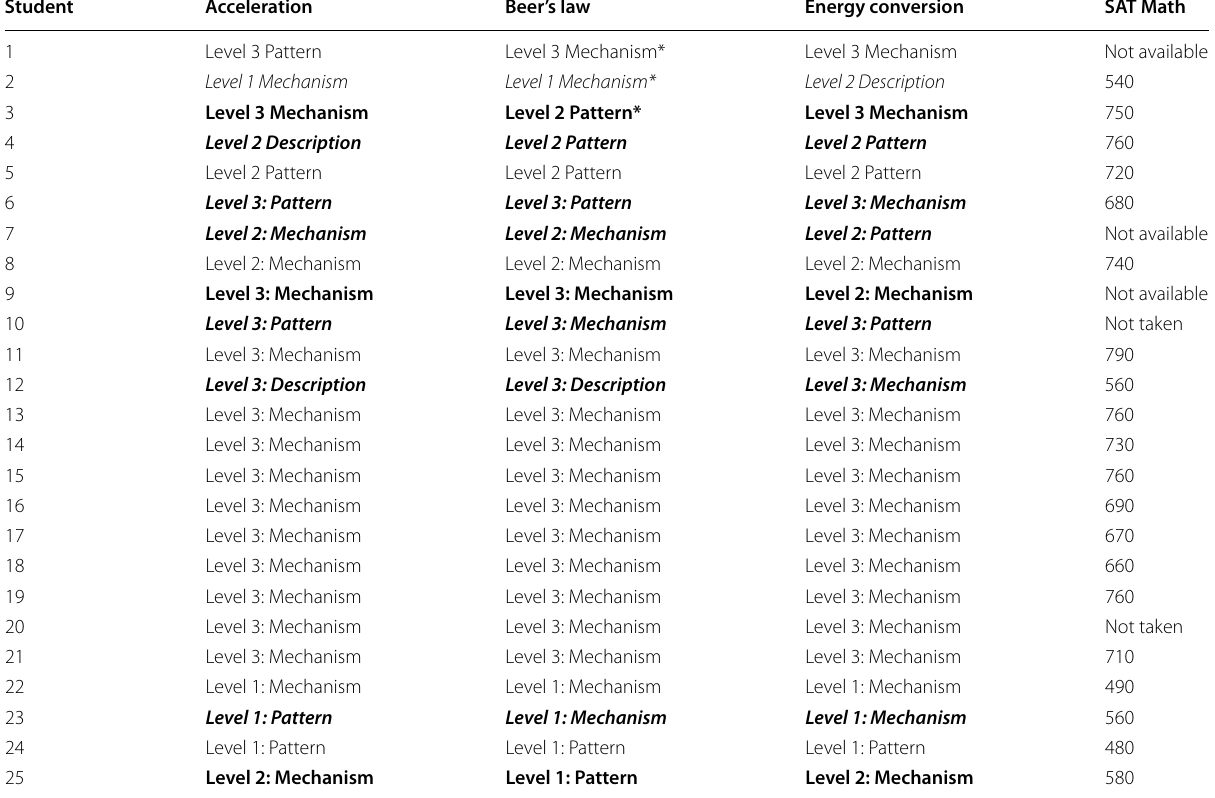
*Students were not provided molar absorption coefficient